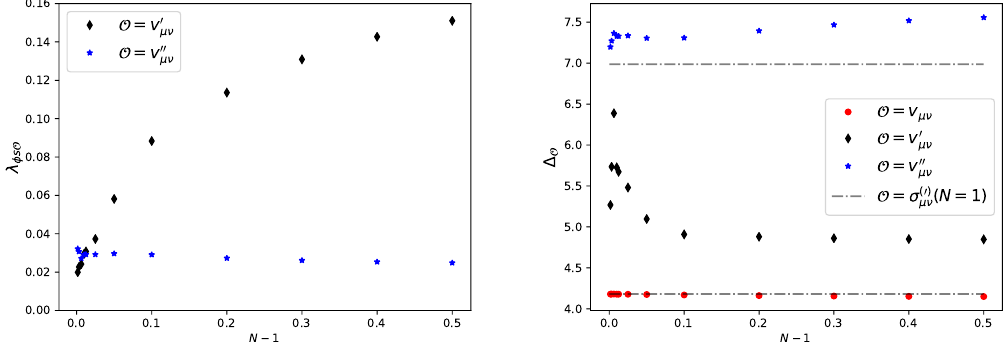
Figure 11: Left: φ × s OPE coefficient of the two subleading spin-2 V primaries. Right: Scaling dimensions of the three lowest-lying spin-2 V primaries. The straight lines indicate the dimensions of the two lowest-lying spin-2 (cid:90) Ising Model according to [ 43 ]